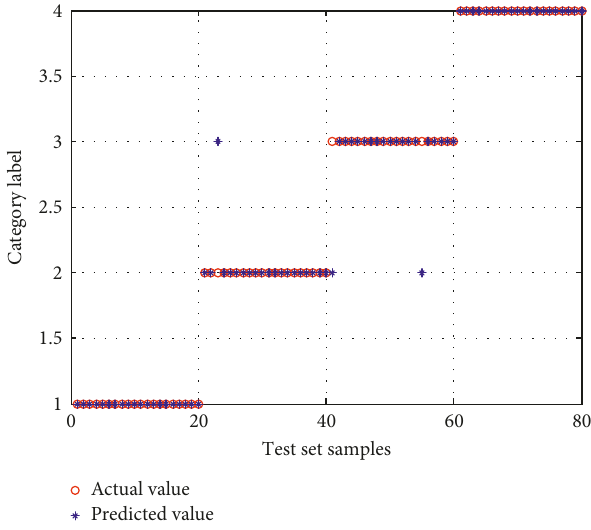
Figure 12: SFLA-SVM predicted